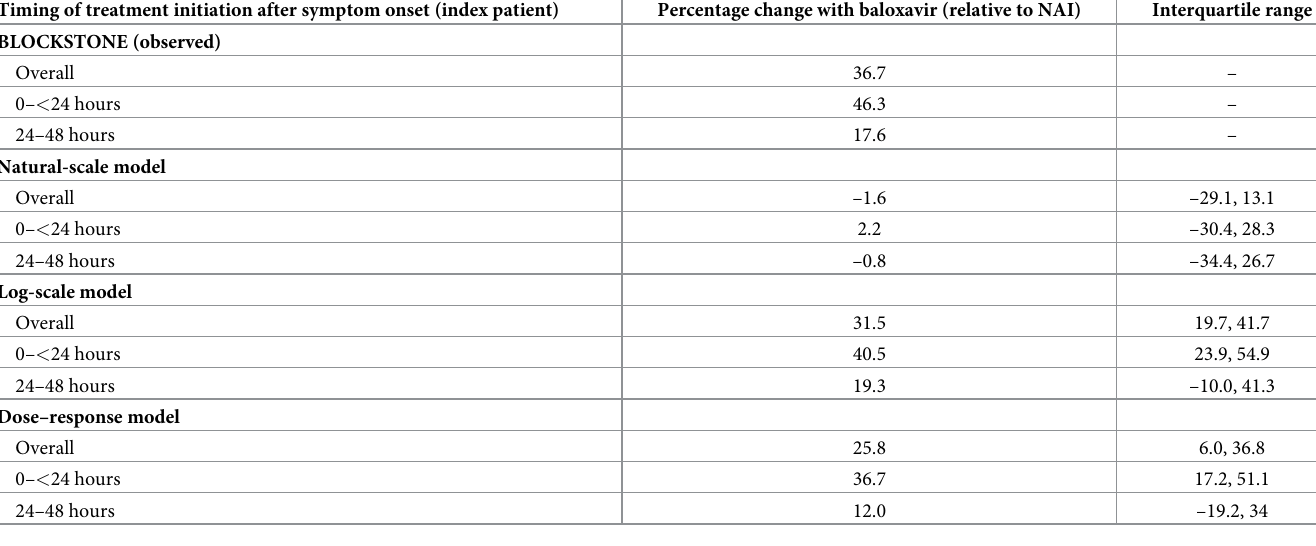
Table 2. Observed and simulated transmission mitigation following treatment of index patients with baloxavir relative to NAI treatment in the BLOCKSTONE study. Timing of treatment initiation after symptom onset (index patient) Percentage change with baloxavir (relative to NAI) Interquartile range BLOCKSTONE (observed)